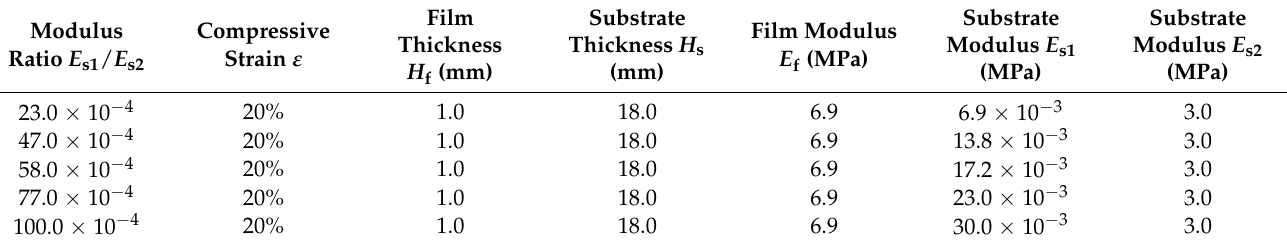
Figure 4. Influence of modulus ratio E s1 / E s2 on the composite instability morphology. Table 2. Different elastic modulus ratios, E s1 / E s2